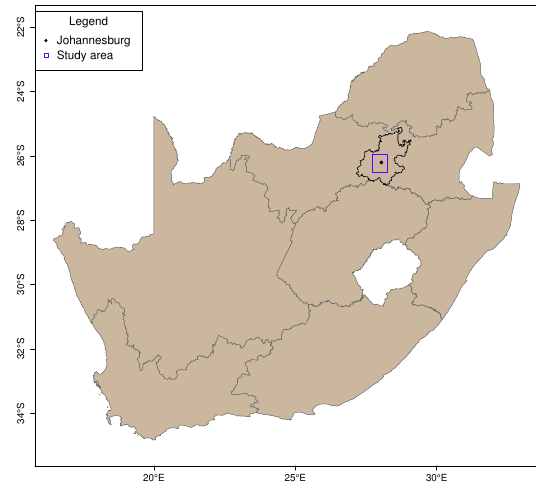
Figure 1: Map of South Africa showing the location of Johannes- burg (denoted by a dot) and the study area as indicated by a blue